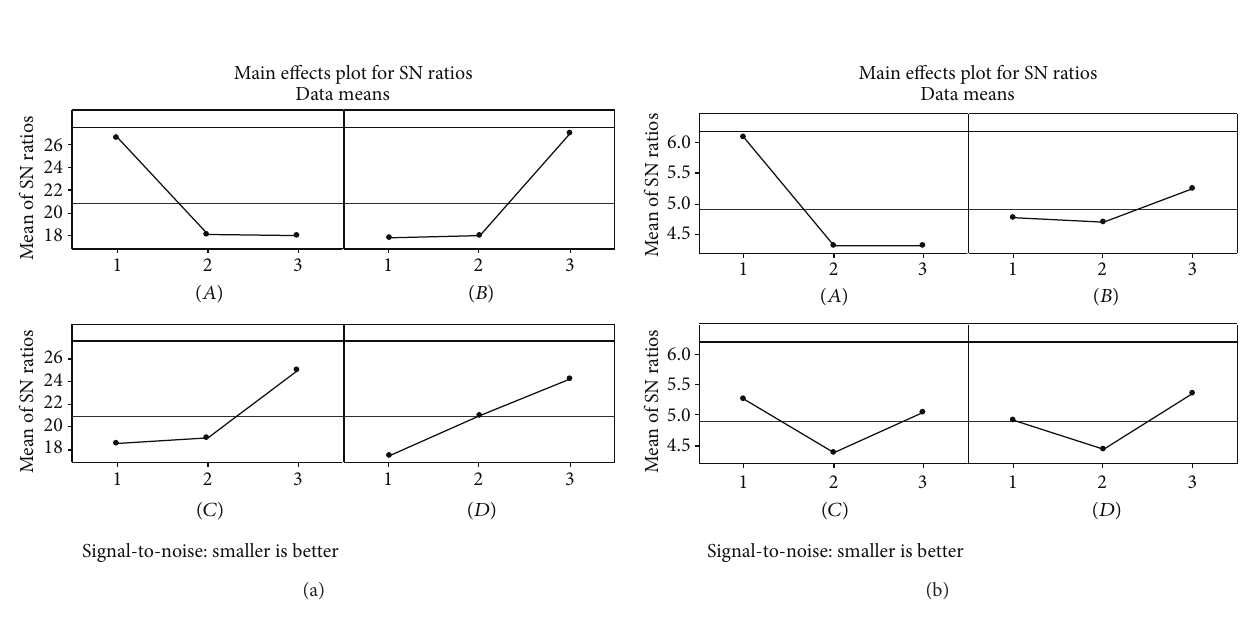
Figure 2: Main effect plot. (a) Specific wear. (b) Coefficient of friction.